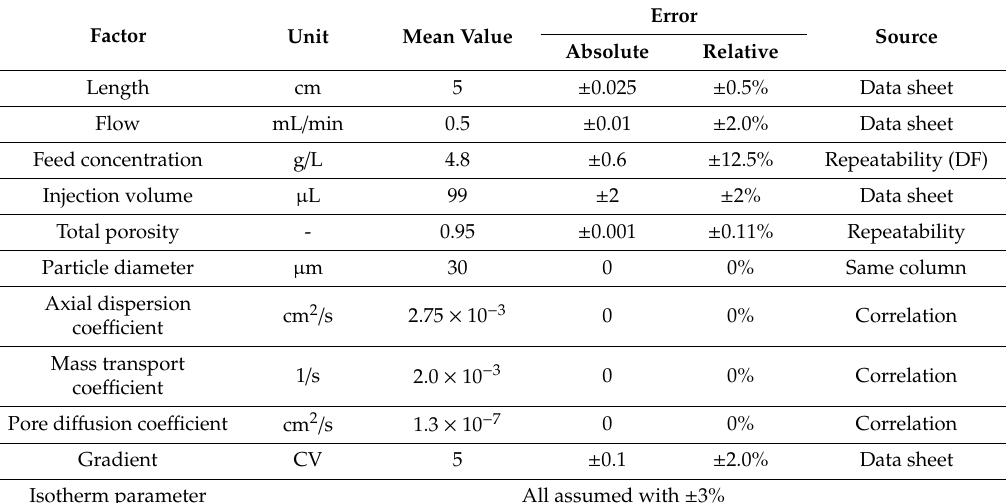
Table 2. Parameters for the 5 CV gradient